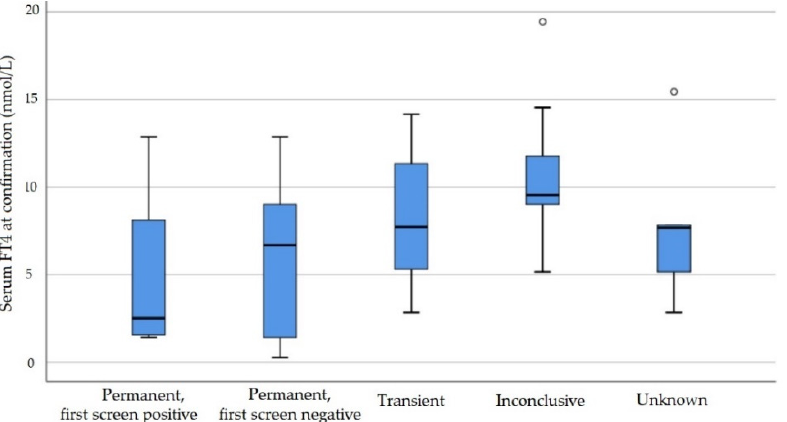
Figure 3. Free T4 values before initiation of treatment (serum, nmol/L). Boxes represent median and interquartile range (IQR). Whiskers range between the minimum and maximum values, excluding outliers >1.5 IQR from the box which are represented by small circles.